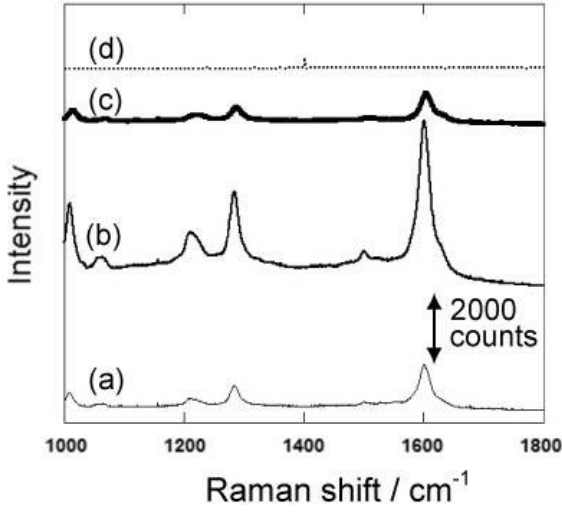
Figure 5. Raman Spectra of 4,4’-bipyridine using the gold nanocarpets with different nanorod lengths. The length of gold nanorods is 300, 600 and 900 nm for the spectra shown as ( a ), ( b ) and ( c ), respectively. The spectrum indicated as ( d ) is obtained with a mirrored gold